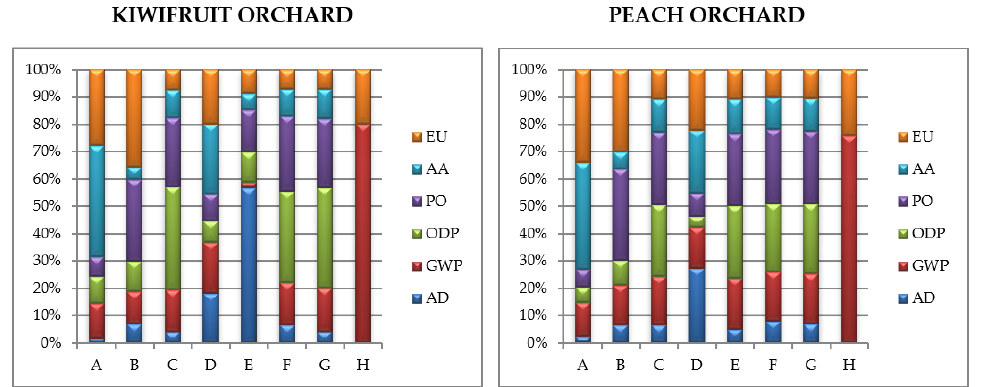
Figure 4. Percentage distribution of environmental impacts by agricultural operation. (A: Soil preparation; B: Plantation, irrigation system and supporting structures installation; C: Weed control and soil tillage; D: Fertilization; E: Diseases control; F; Harvesting; G: Trees explants; H: Crop residues; EU: Eutrophication; AA: Air Acidification; PO: Photochemical oxidation; ODP: Ozone layer depletion; GWP: Global warming potential; AD: Abiotic depletion).